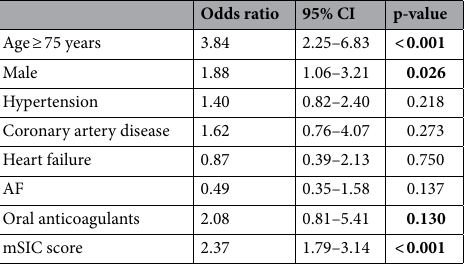
Table 3. Multivariable logistic regression analysis. AF Atrial Fibrillation, mSIC modified Sepsis-Induced Coagulopathy score. Bold values indicate p < 0.05.